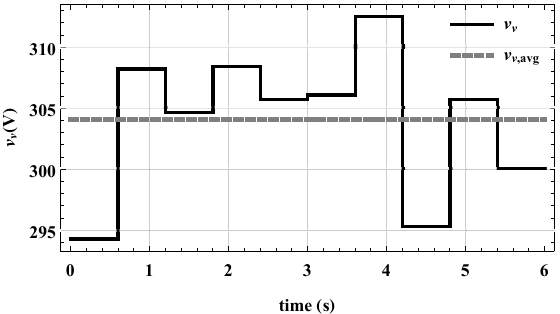
Figure 3. Source voltage v v ,1 and its average value.